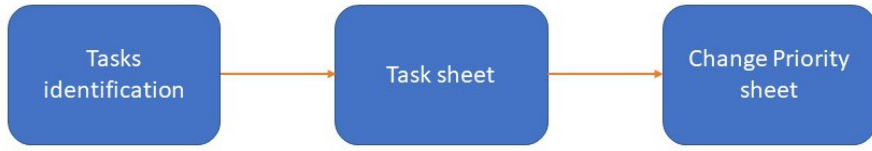
Figure 1. Flowchart of the Suzanne Rodgers